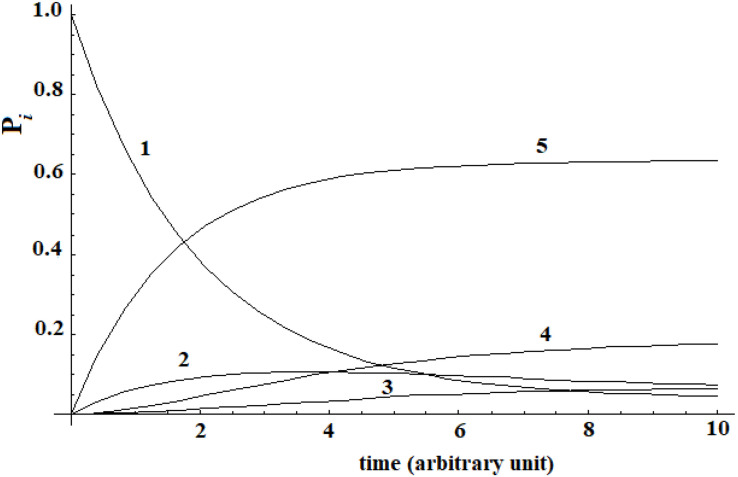
Kinetic of five-states model of Buch et al. (2011) that we have computed.